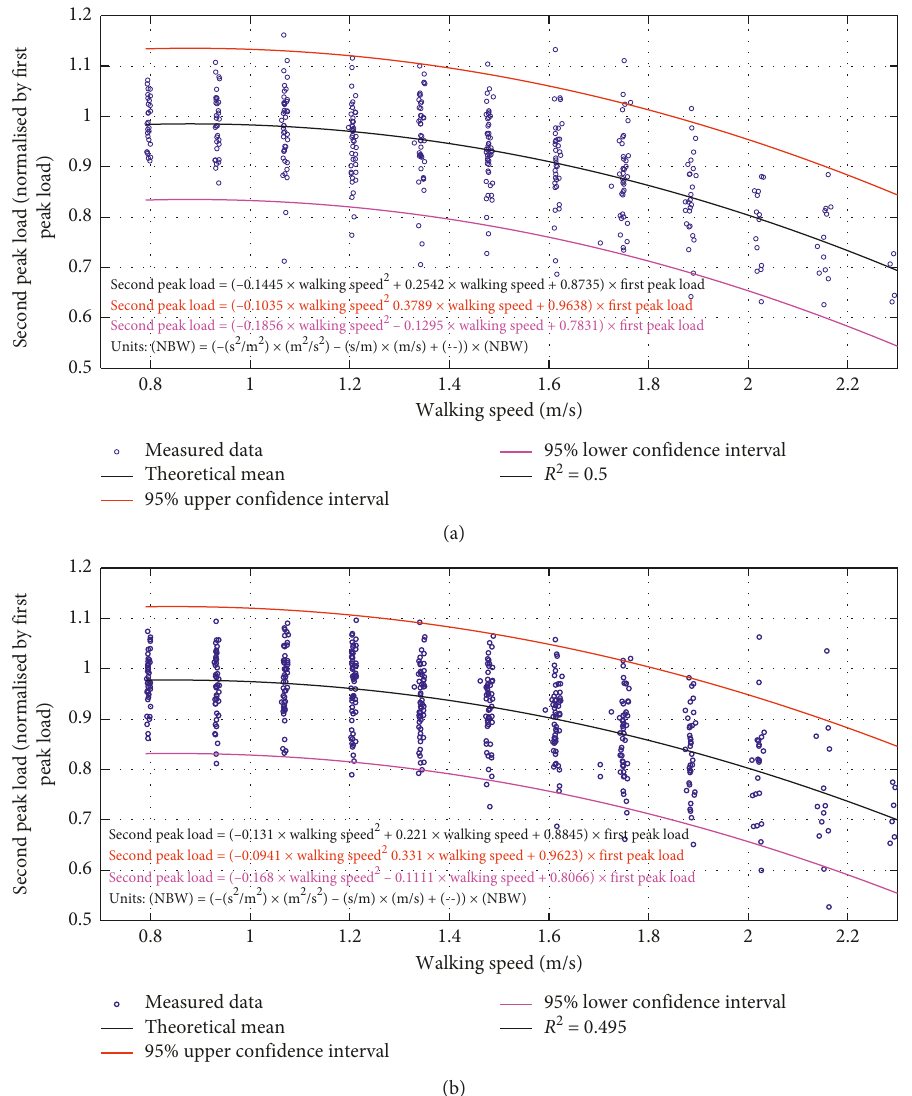
Figure 9: Statistical relationship between walking speed and second peak load. (a) Right footfall; (b) left footfall. Table 1: Intermediate points between the five control points. Points